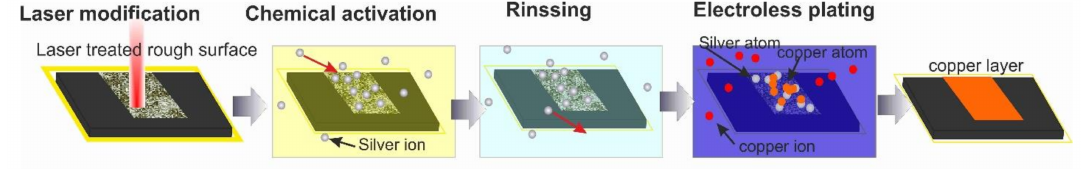
Figure 1. Steps of selective surface activation induced by laser (SSAIL) process: laser modification, chemical activation by dipping in the aqueous solution of silver nitrate, rinsing in distilled water and electroless copper deposition in the